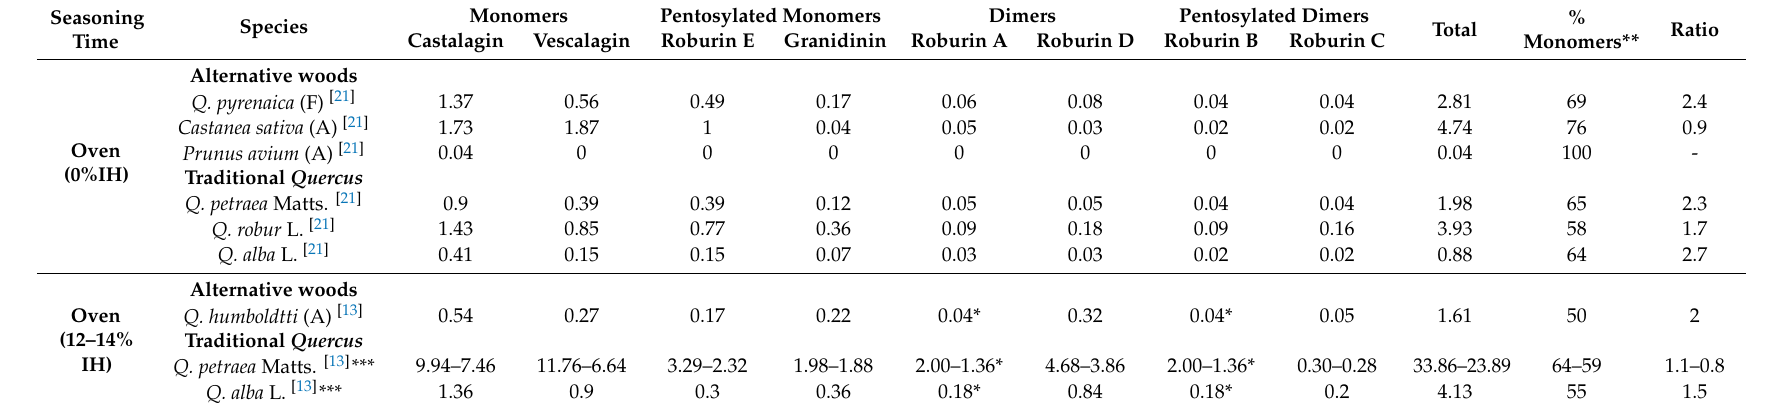
Table 3. Mean of the concentration expressed as mg / g of the ellagitannins found in seasoned woods of di ff erent botanical